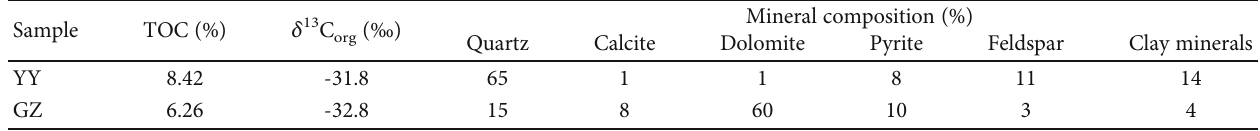
Table 1: Geochemical data and initial mineralogical composition of the two shale samples. Mineral composition (%) Sample TOC (%) δ 13 C ( ‰ ) org Quartz Calcite Dolomite Pyrite Feldspar Clay minerals